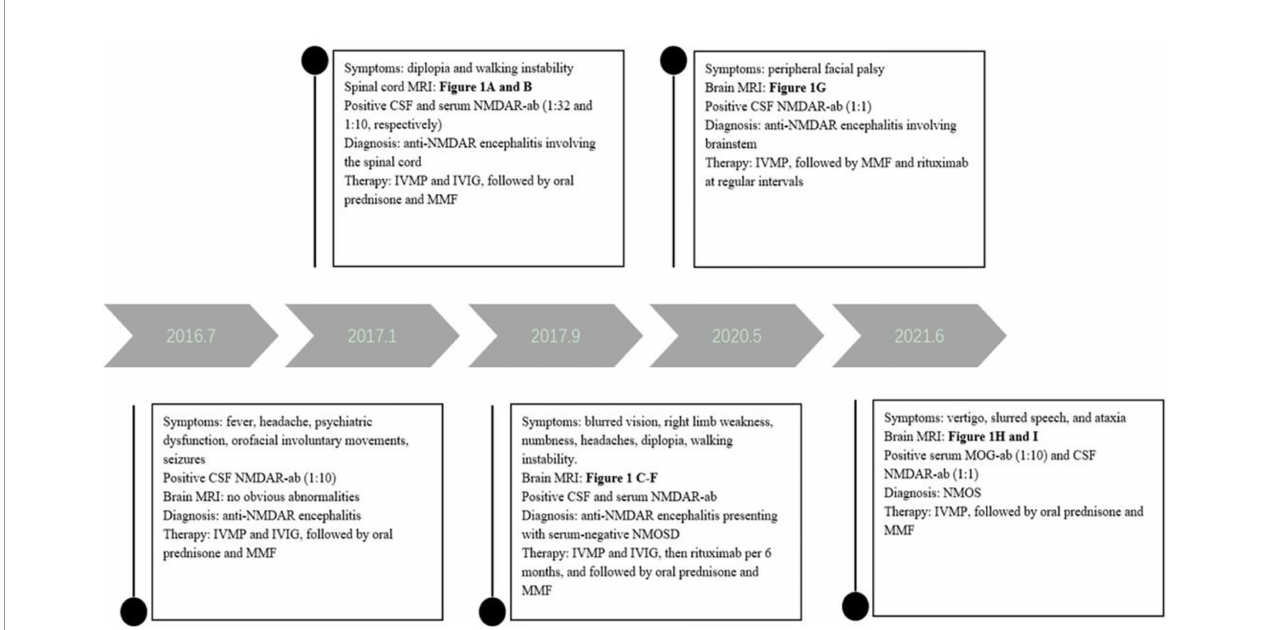
FIGURE 2 | The timeline of relevant results and interventions during the diagnosis and treatment of our